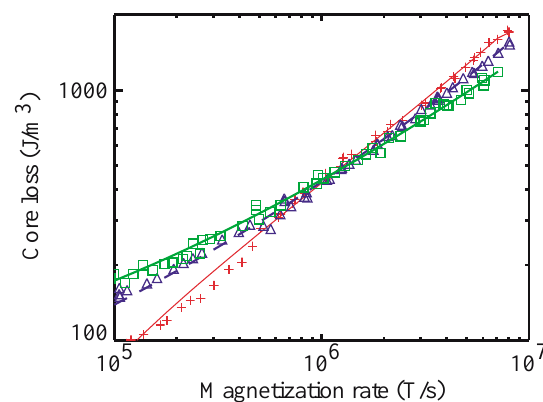
FIG. 13. (Color) Core loss versus magnetization rate for three METGLAS 2605 SA1 cores, The data are for the listed flux swings: ( (cid:1) , green, heavy line) MRTI SA1-04 at 1.75 T; ( (cid:3) , blue, dashed line) MRTI SA1-02 at 2.10 T; and ( 1 , red, solid line) MRTI SA1-01 at 2.20 T. especially for tapes that are narrower than the buildup.